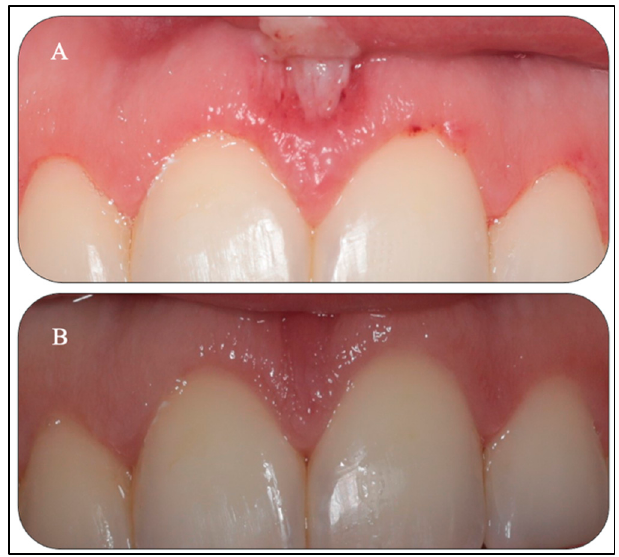
Figure 8. ( A , B ).Clinical photo ( A ) reveals the healing status at the fourth day post-laser treatments, where the healing status of marginal gingival tissues of the #11, #12,# 21, and # 22 was grade IV, and the upper midline frenum shows re-epithelisation (grade IV), indicating an acceleration of the healing process. Clinical photo ( B ) reveals a complete healing of the upper midline frenum (Garde V) and great wound healing progress towards complete wound healing of the gingival margin of #11, #21, #12, and #22 (grade IV) at two weeks post-treatments.